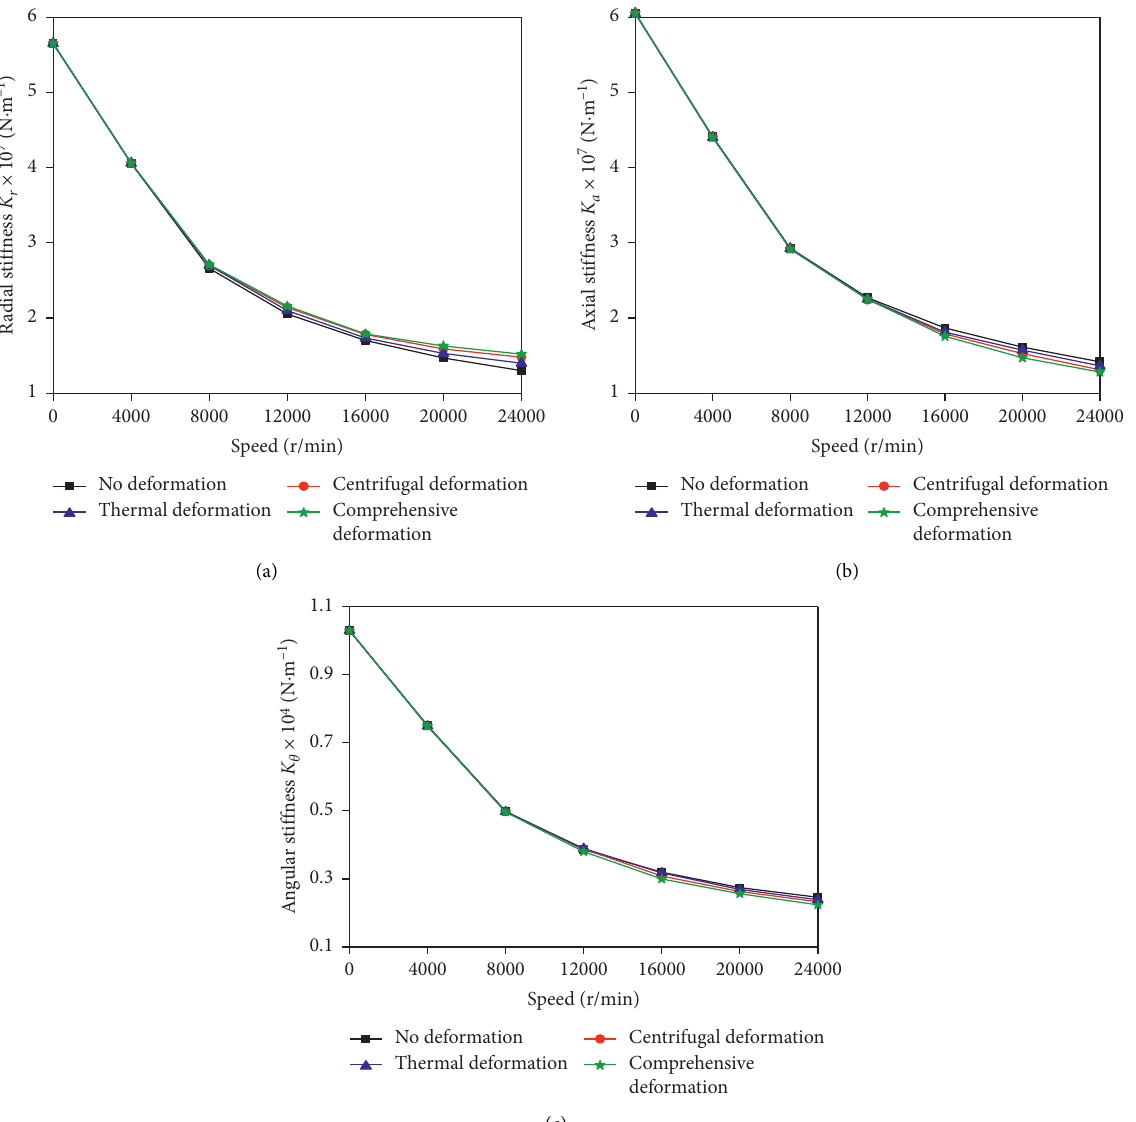
Figure 23: Influences of the speed and deformation on the composite stiffness. (a) Radial stiffness. (b) Axial stiffness. (c) Angular